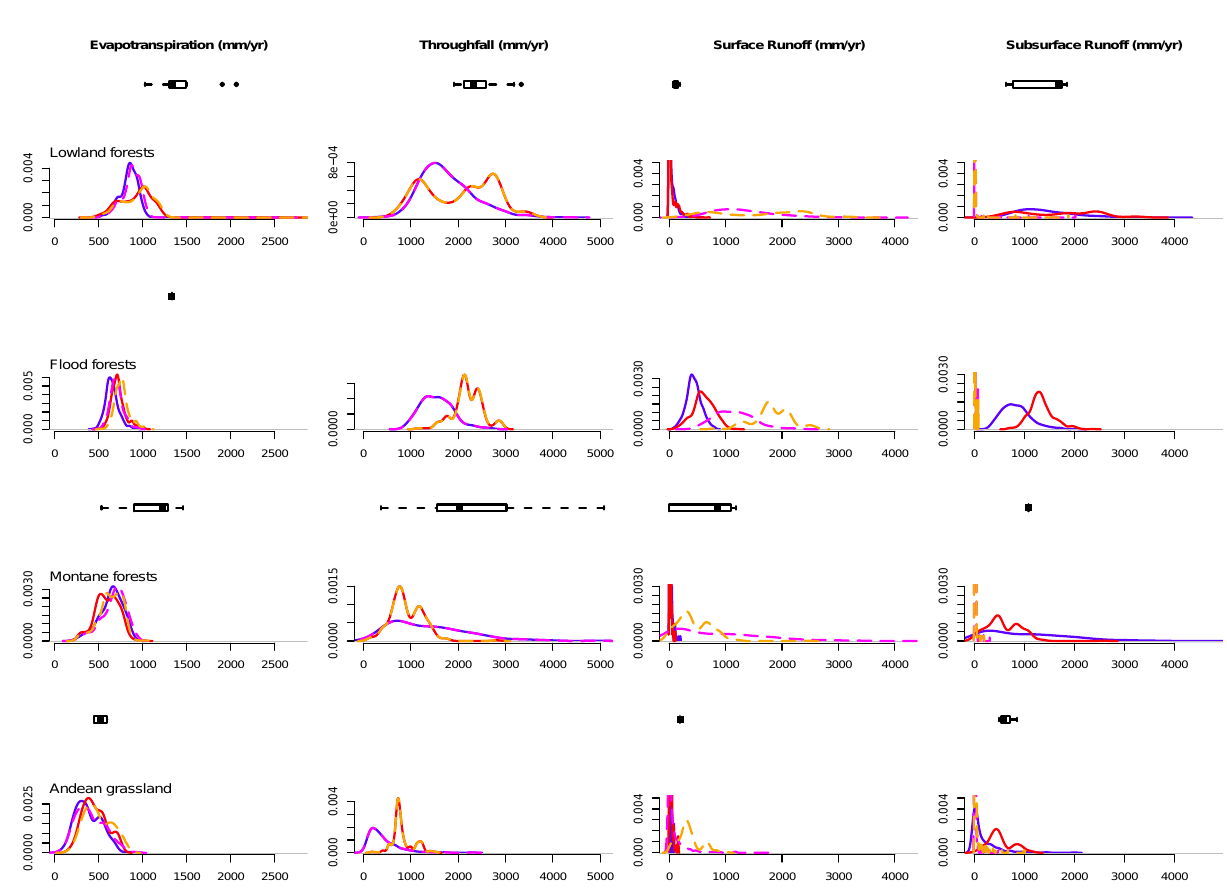
Fig. 8. Internal basin’s surface fluxes simulated by JULES compared with the variability found in the literature. Each subfigure is a kernel density plot of the surface hydrological fluxes in each biome, juxtaposed with a box plot of the distribution of published values from different world locations (Table 4). Blue: JULES-BASE and TRMM, magenta: JULES-TOPMODEL and TRMM, red: JULES-BASE and NCEP, orange: JULES-TOPMODEL and